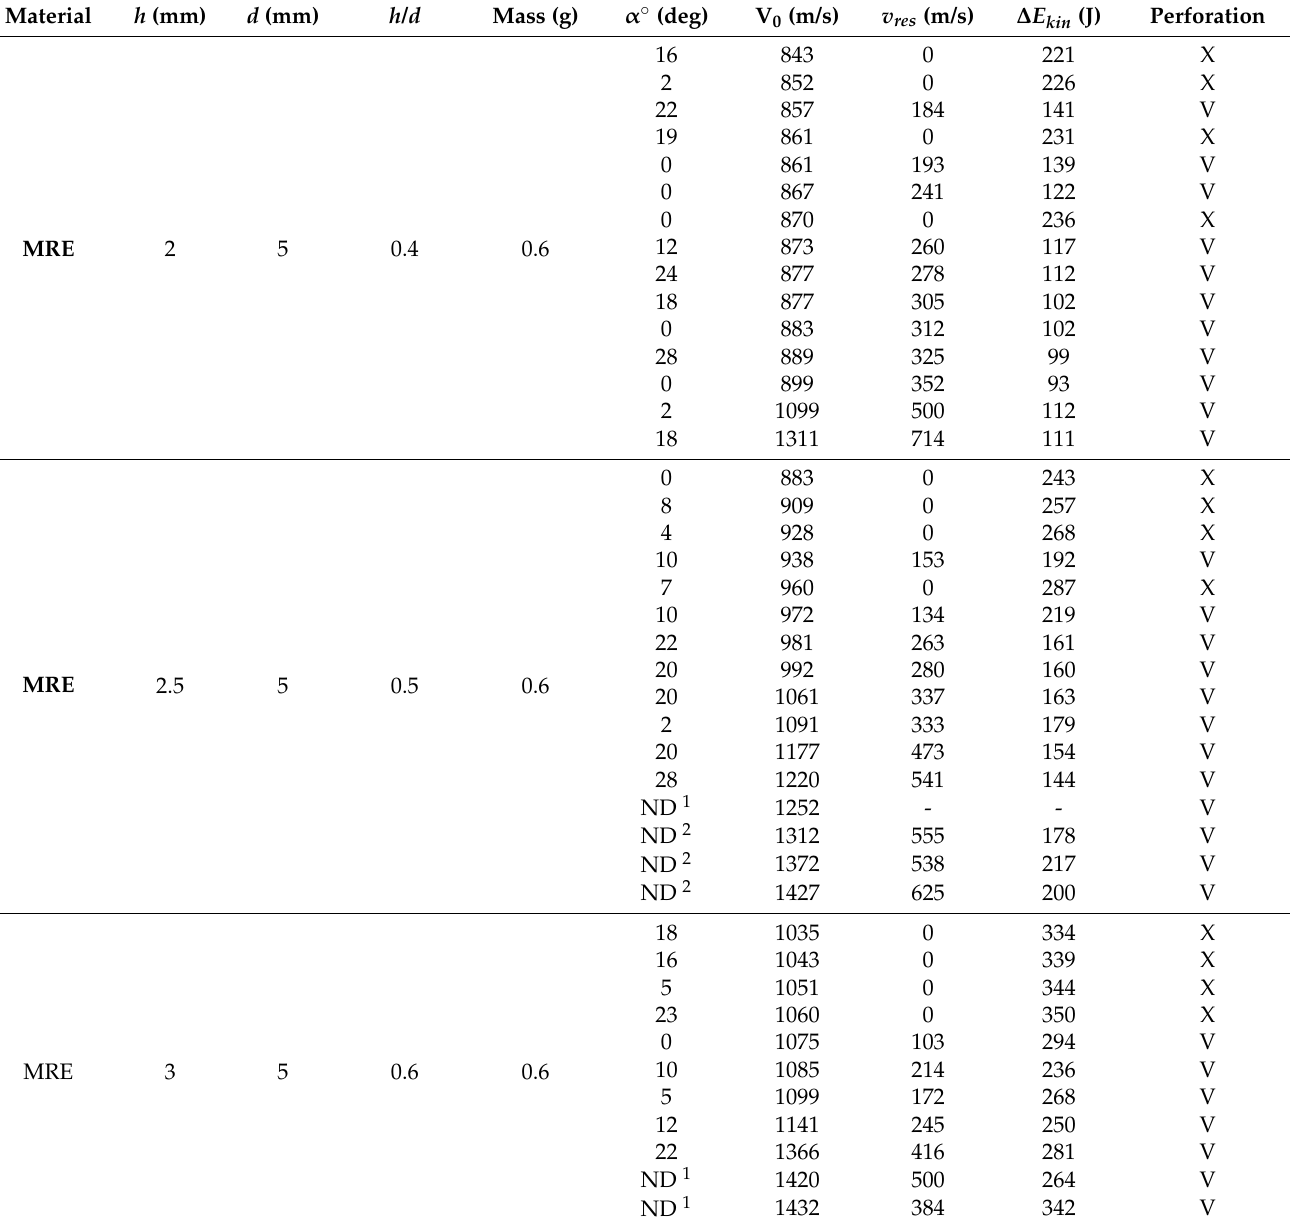
Table 2. Summary of experimental